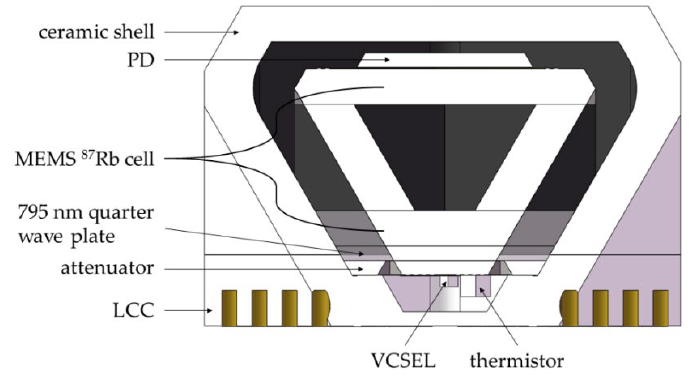
Figure 1. Design of the physics package.